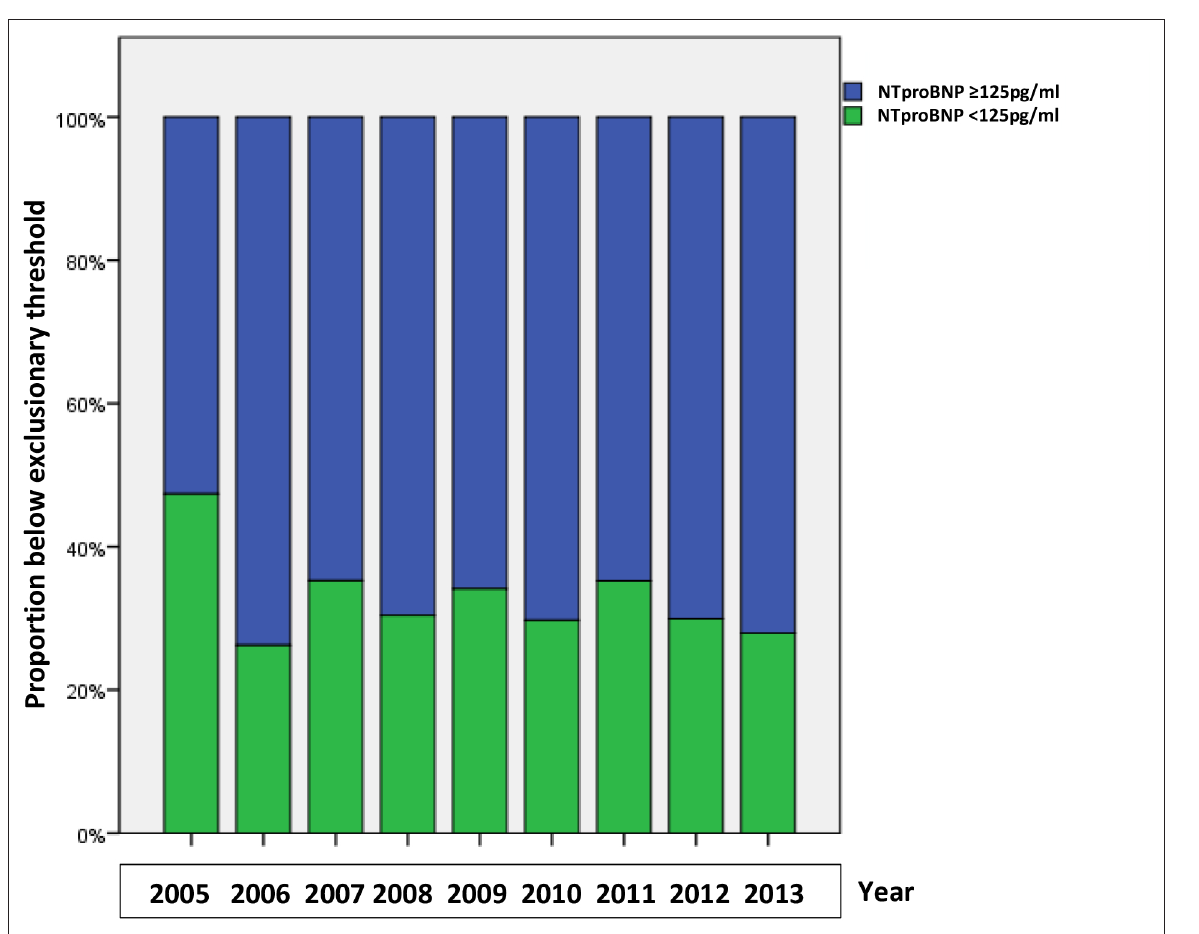
Figure 2 Proportion of the participating GPs ordered NTproBNP values above and below the exclusionary threshold of 125 pg/ml for each year from